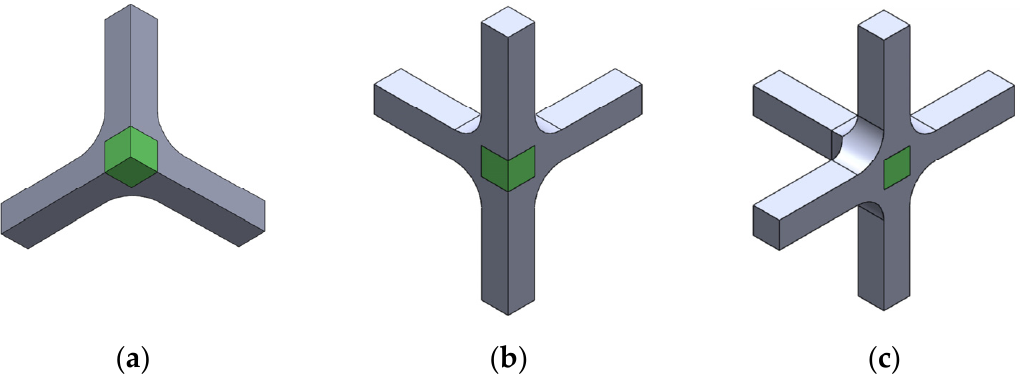
Figure 5. Free surfaces for strain measurement in geometry A: ( a ) CCC loading case; ( b ) CTC loading case; and ( c ) CTT loading case.